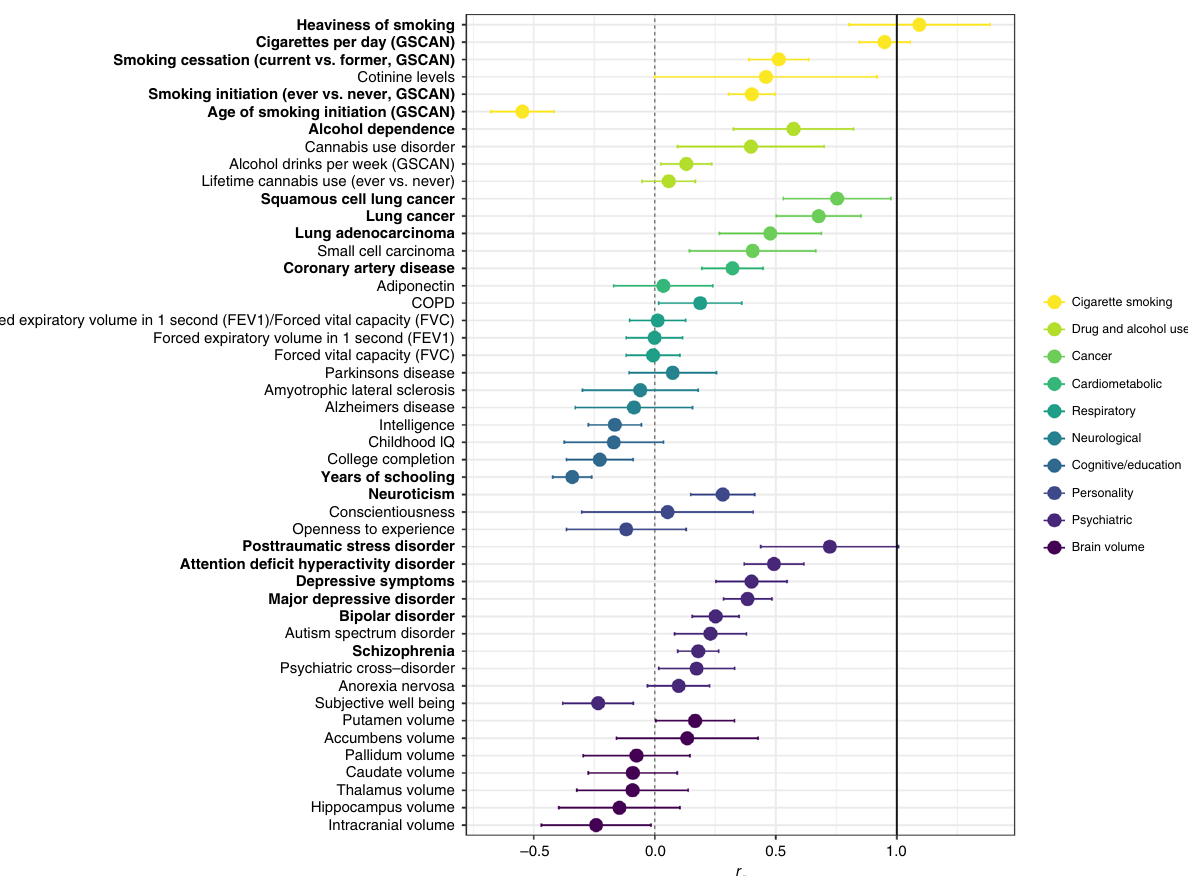
Fig. 3 Genetic correlations of nicotine dependence (ND) with 47 other phenotypes. Correlations were calculated using linkage disequilibrium (LD) score regression with the iNDiGO European ancestry-speci fi c GWAS meta-analysis results for ND ( N = 46,213 biologically independent samples), compared with results made available via LD Hub or study investigators (see Supplementary Table 7 for original references). Phenotypes were grouped by disease/ trait or measurement category, as indicated by different colorings. Dots indicate the mean values for genetic correlation ( r g ); error bars show the 95% con fi dence intervals; the dashed vertical black line corresponds to r g = 0 (no correlation with ND), and the solid vertical black line corresponds to r g = 0 (complete correlation with ND). Phenotypes with signi fi cant correlation with ND are bolded (1 degree of freedom Chi-square test; Bonferroni adjusted p -value <0.05 after accounting for 47 independent tests). Exact p -values are provided in Supplementary Table